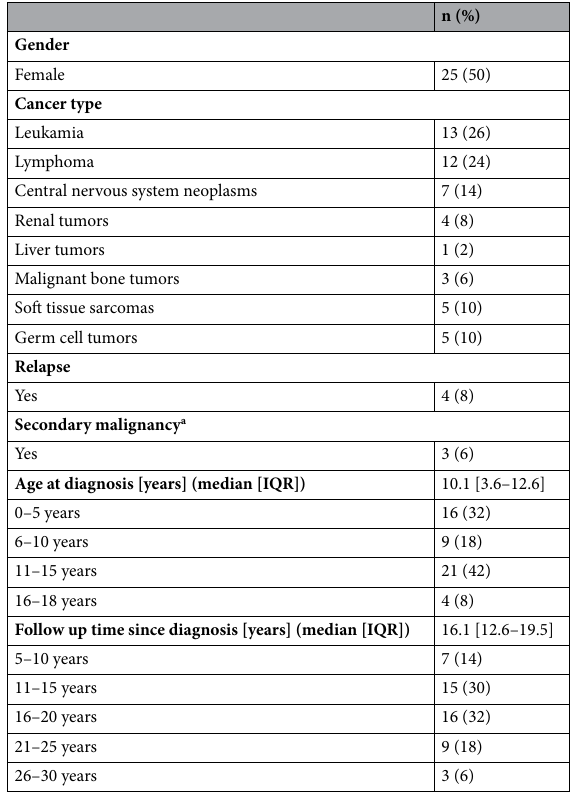
Table 1. Clinical characteristics of participating childhood cancer survivors (N = 50). a